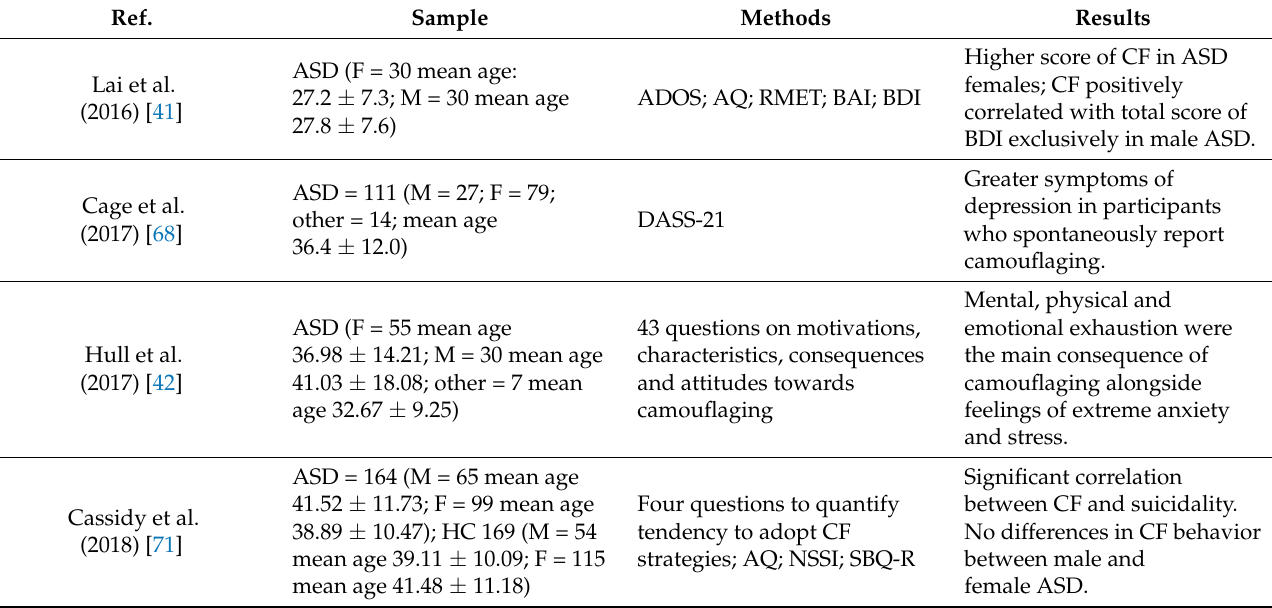
Table 2. The available literature on Social Camouflaging (Part 2). Ref. Sample Methods Results